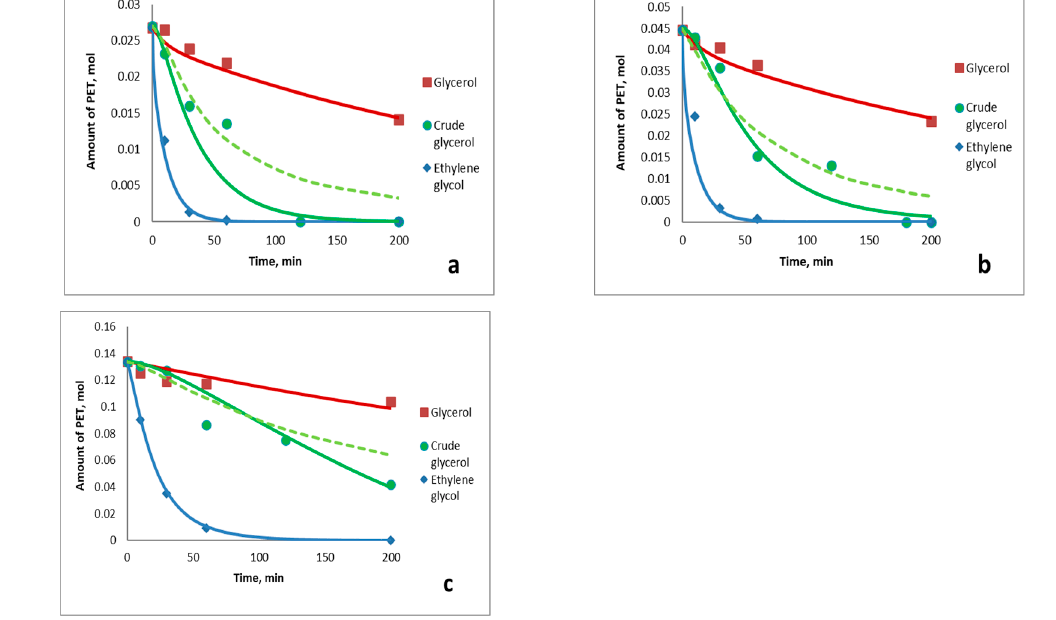
Figure 10. Experimental (dots) and calculated amounts of PET in different polyols according to previous (dotted) and new (solid) models at different reaction conditions: ( a ): 170 ◦ C PET/KSt = 0.3; ( b ): 170 ◦ C PET/KSt = 0.5; ( c ): 170 ◦ C PET/KSt =